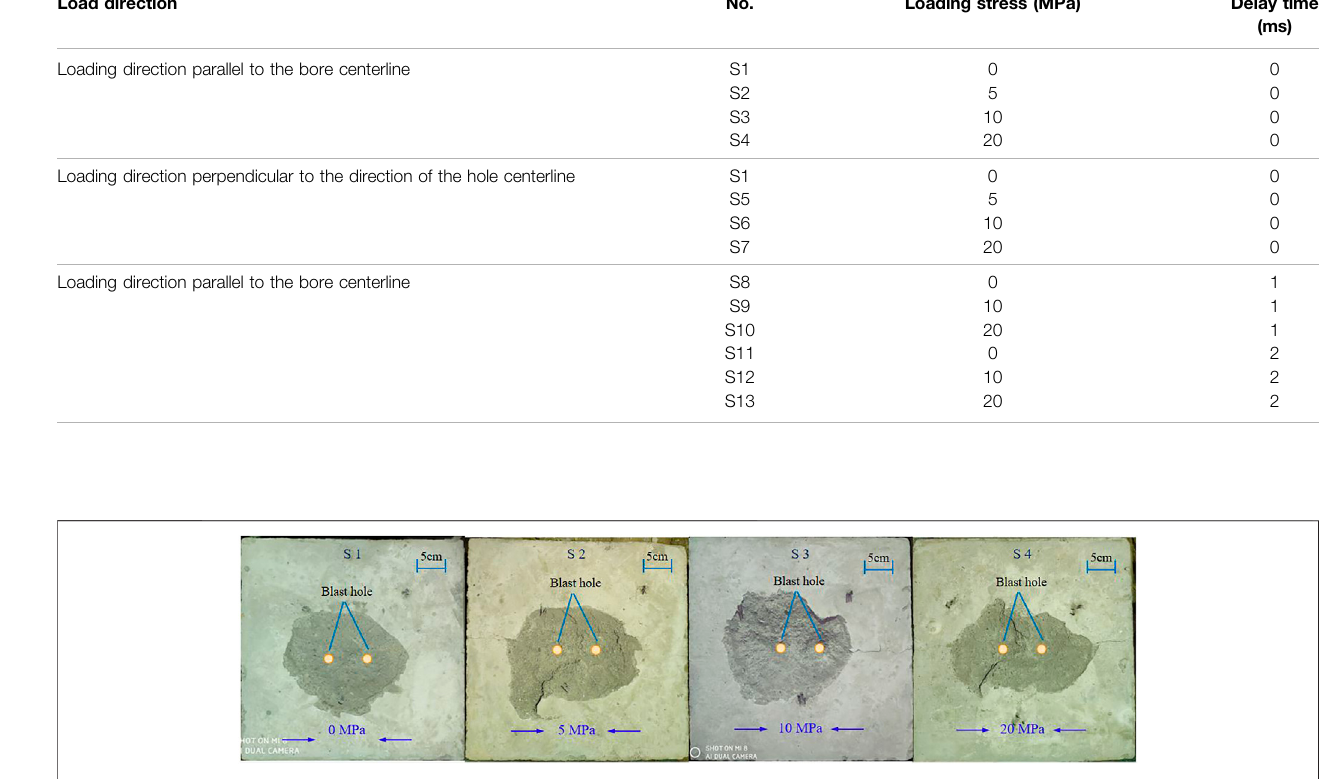
TABLE 1 | Experimental scheme of the double-hole crater under the stress condition. Load direction No.